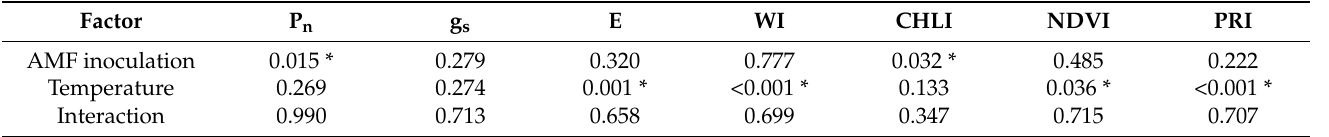
Table 1. p -Values of the two-way ANOVA test for the effects of the main factors and their interaction in grapevine physiological parameters and reflectance